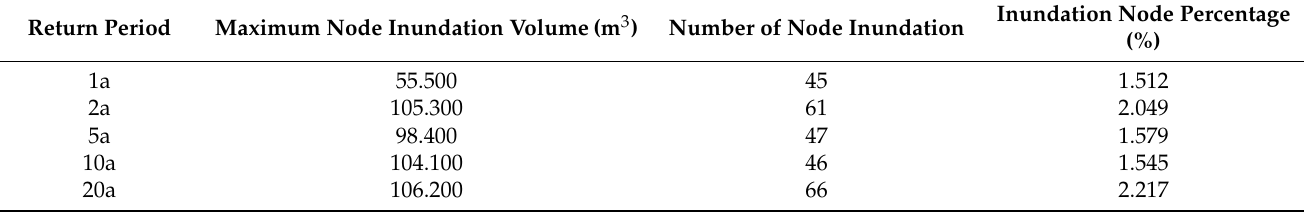
Figure 5. The spatial distribution of inundation nodes. ( a ) 2a return period under RF period. ( b ) 2a return period under RCP4.5. ( c ) 2a return period under RCP8.5. ( d ) 20a return period under RF period. ( e ) 20a return period under RCP4.5. ( f ) 20a return period under RCP8.5. Table 9. The results of inundation node (RCP4.5 relative to RF).